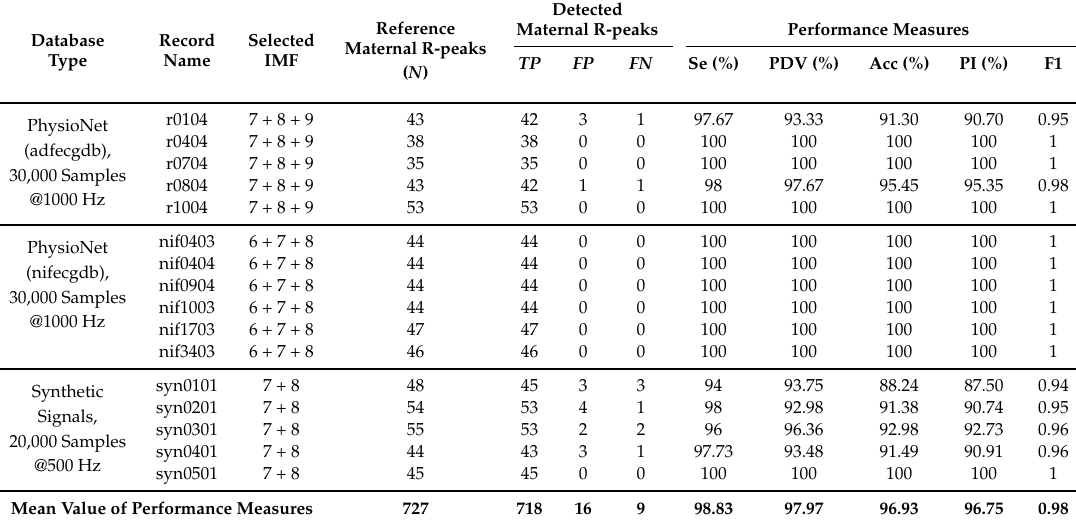
Table 4. Results of the maternal R-peak detection and its various performance measures. Se, Sensitivity; PDV, Positive Diagnostic Value; PI, Performance Index; r, recording.